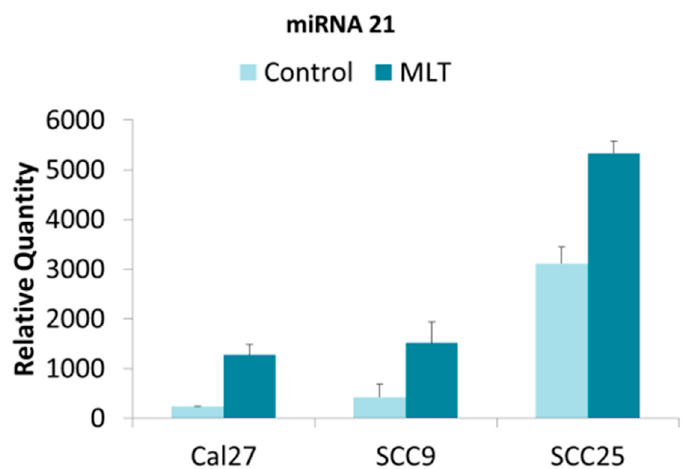
Figure 1. Relative miR-21 expression in oral cancers under melatonin (MLT) administration. Histogram of quantitative PCR from cDNAs derived from extracellular vesicles demonstrated differential baseline expression of miR-21 including standard deviation (SD), which was significantly increased in all cell lines under melatonin administration, p < 0.05 (CAL27, p < 0.001; SCC9, p < 0.001; SCC25, p < 0.001).